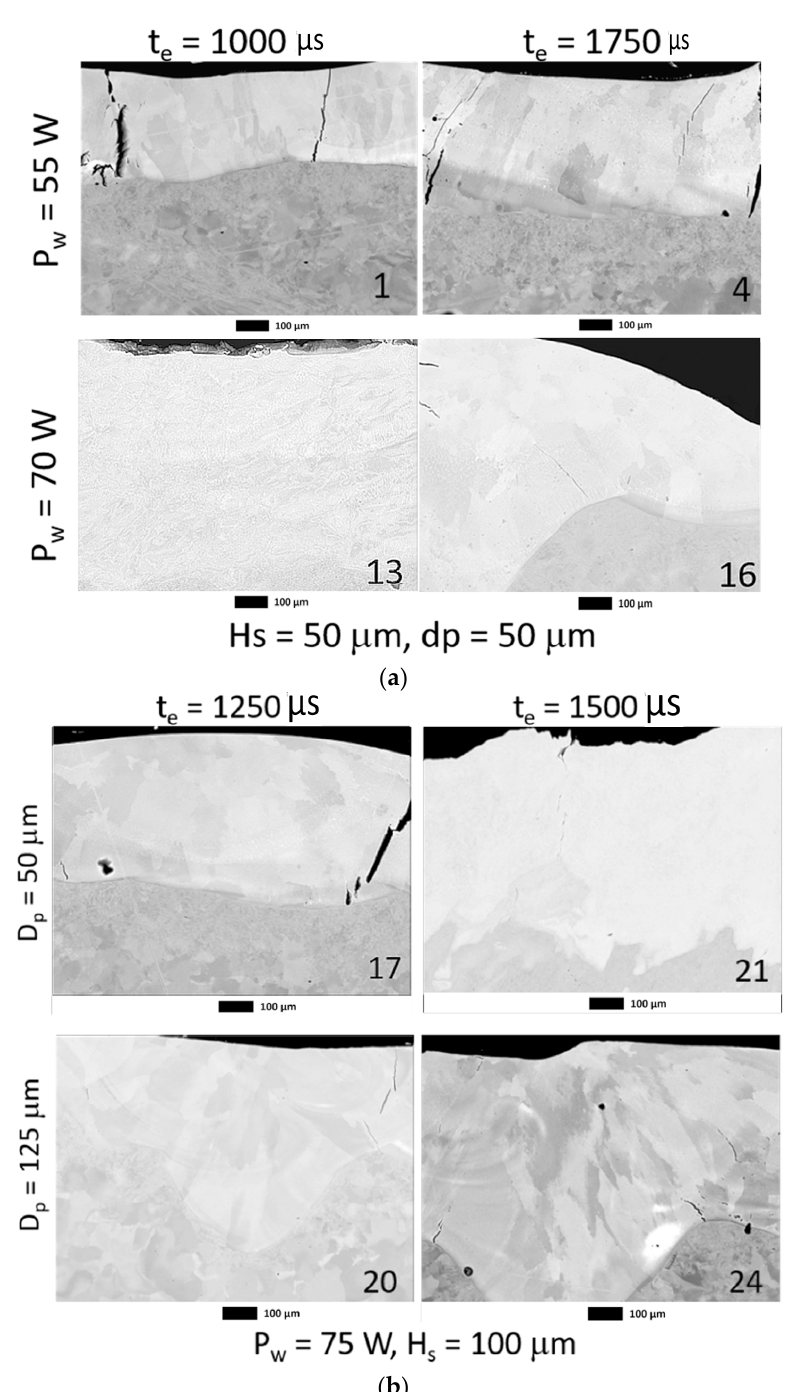
Figure 8. Images of the cross-section of coatings obtained by optical microscopy. The number ( a ) for H s = 50 µm and d p = 50 µm ( b ) P w = 75 W and H s = 100 µm.